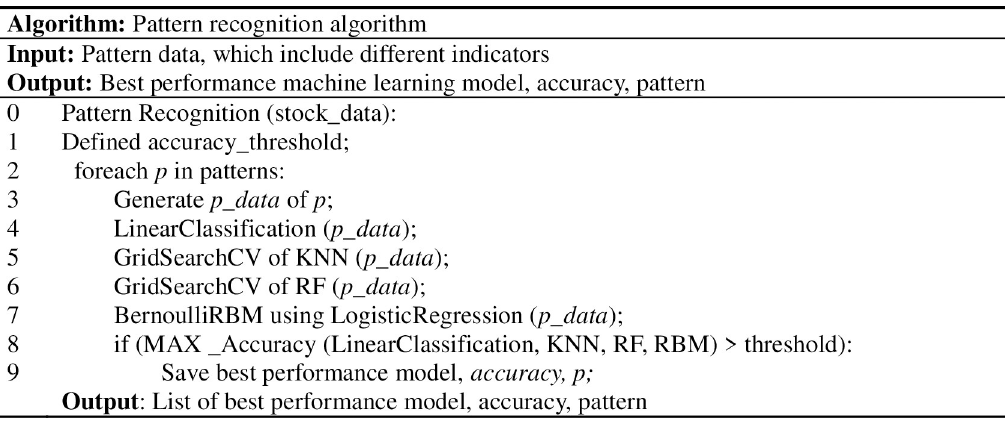
Fig 2. Main pattern recognition